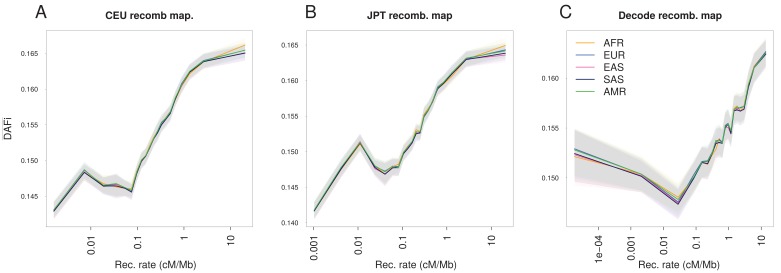
The increase of DAFi¯ with recombination rate is robust to the choice of the recombination map.Panels are analogous to Figure 1A, but based on different recombination maps. (A) LD-based HapMap recombination map derived from a European population (CEU, log-linear regression). (B) LD-based HapMap recombination map derived from a Japanese population (JPTC) Pedigree-based sex-averaged recombination map from deCODE (Kong et al., 2010; Wegmann et al., 2011). DAFi¯ increases almost linearly with the logarithm of the recombination rate except for the lowest recombination class (<0.1 cM/Mb for all three maps), which could be due to the difficulty in estimating very low-recombination rates with both LD-based and pedigree-based methods. Both methods are likely to miss rare recombination events, such that the true recombination rate around some SNPs of the lowest recombination class could be higher than that reported. Shaded areas represent the 95% confidence interval of each group of individuals estimated using a block-bootstrap approach (see Materials and methods).